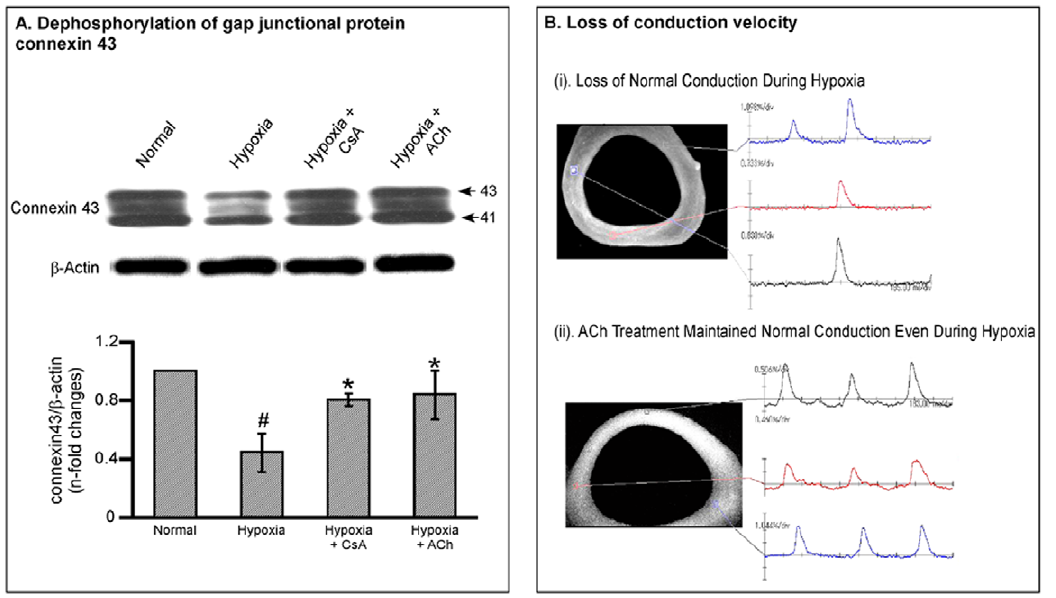
Figure 3. Response of EHT to hypoxic stress. A. Representative Immunoblotting analysis of connexin 43 in EHTs subjected to hypoxic stresses. Arrows indicate positions of phosphorylated isoform of connexin 43 (43 kDa) and nonphosphorylated isoform of connexin 43 (41 kDa) bands, respectively. Quantitative densitometric analysis represents the phosphorylated isoform of connexin 43. Values are mean 6 SD # P , 0.05 versus normal group and * P , 0.05 versus hypoxic group. N=5 in each group. B. Representative images showing the conduction defect evaluated by optical mapping, following exposure of EHTs to hypoxia, which was reverted by treatment with ACh. The synchronous conduction was lost in the EHT subjected to hypoxia. However, treatment with ACh prevented the conduction defect.